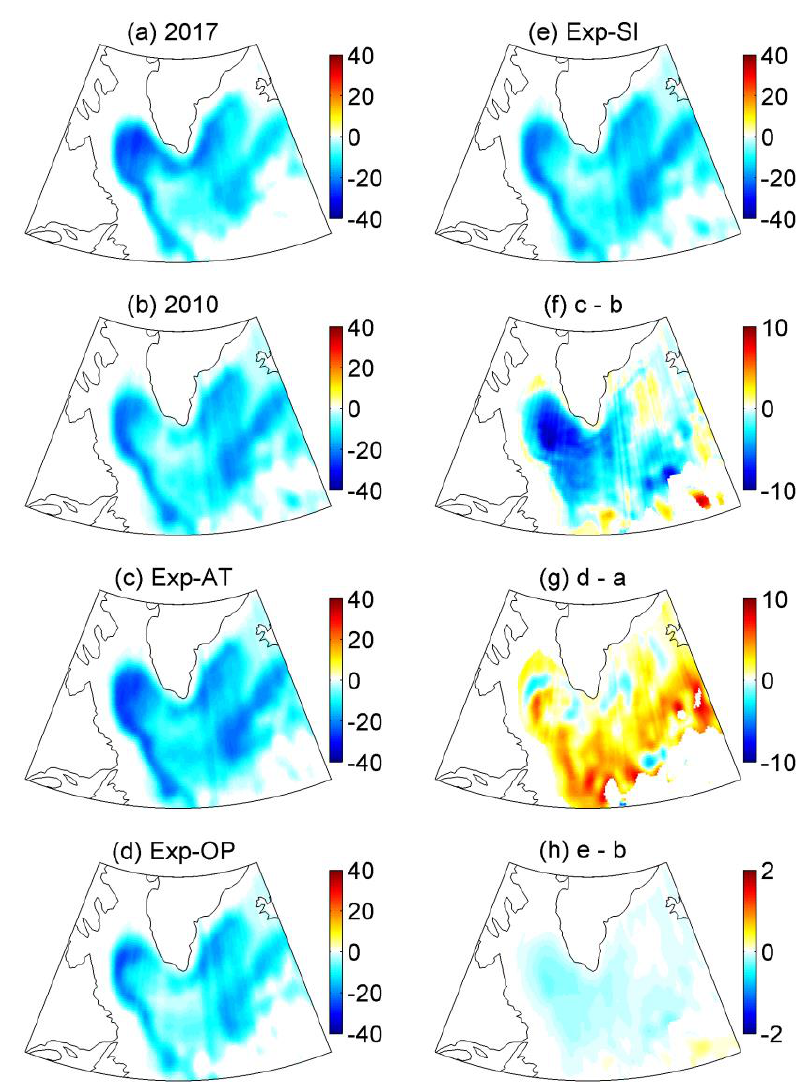
Figure 6. The same as in Figure 4, but for the barotropic stream function (Sv).